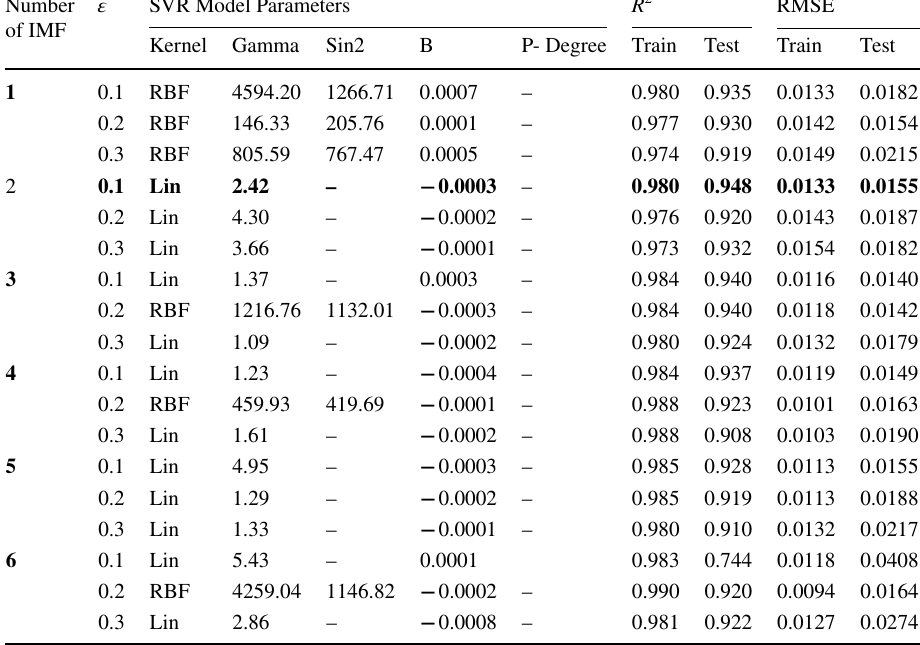
Bold values represent the